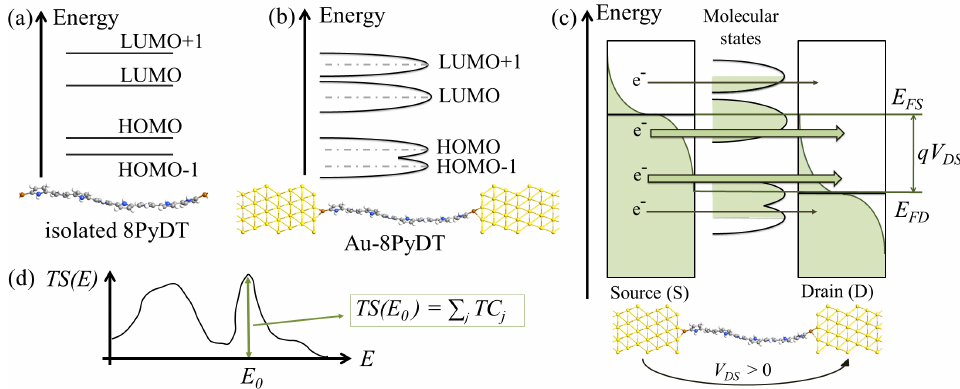
Figure 2. Pictorial representations of ( a ) discrete energy states of an isolated molecule (e.g., 8PyDT) and ( b ) broadened states of a molecular junction (e.g., Au-8PyDT junction). ( c ) Pictorial representation of the V DS effect in the Au-8PyDT. Transmission occurs mainly at energy E in between E FD and E FS . Less transmission occurs at E > E FS and E < E FD due to the limited presence of occupied states in S and free states in D. ( d ) Pictorial representation of an example of the TS ( E ) function. At each fixed energy E 0 , the TS ( E 0 ) value is the superposition of the transmission probabilities (transmission eigenvalues) of the possible transmitting states (transmission